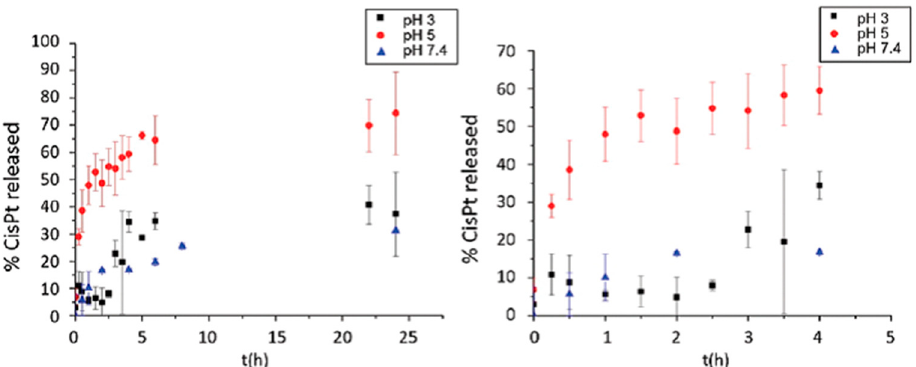
Figure 11. CisPt release from NiPAm-based nanogel (an enhanced image of the release plots is shown in the right panel). Adapted from G.N. Rimondino et al. [25].